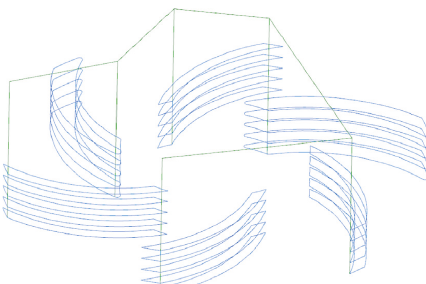
Figure 23: Slices of the impeller with embedded substrate build strategy.